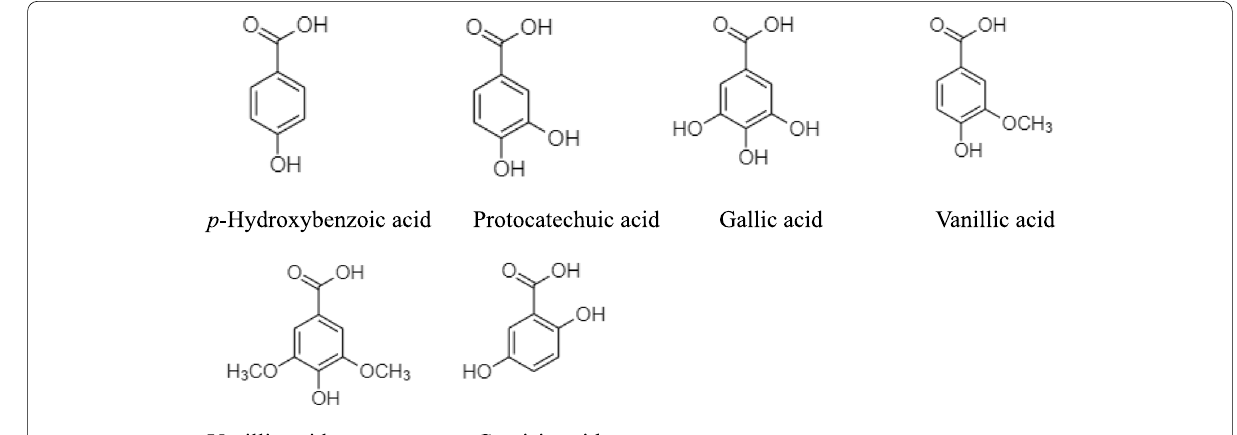
Fig. 2 Chemical structures of hydroxybenzoic acid derivatives